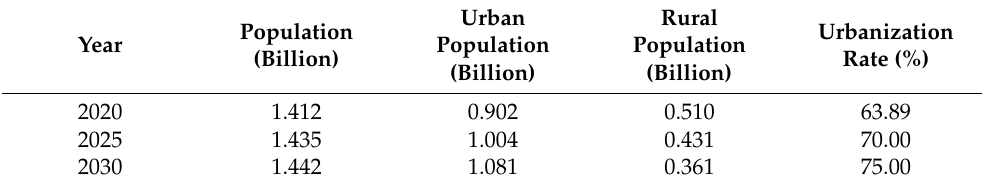
Table 4. The prediction of population in